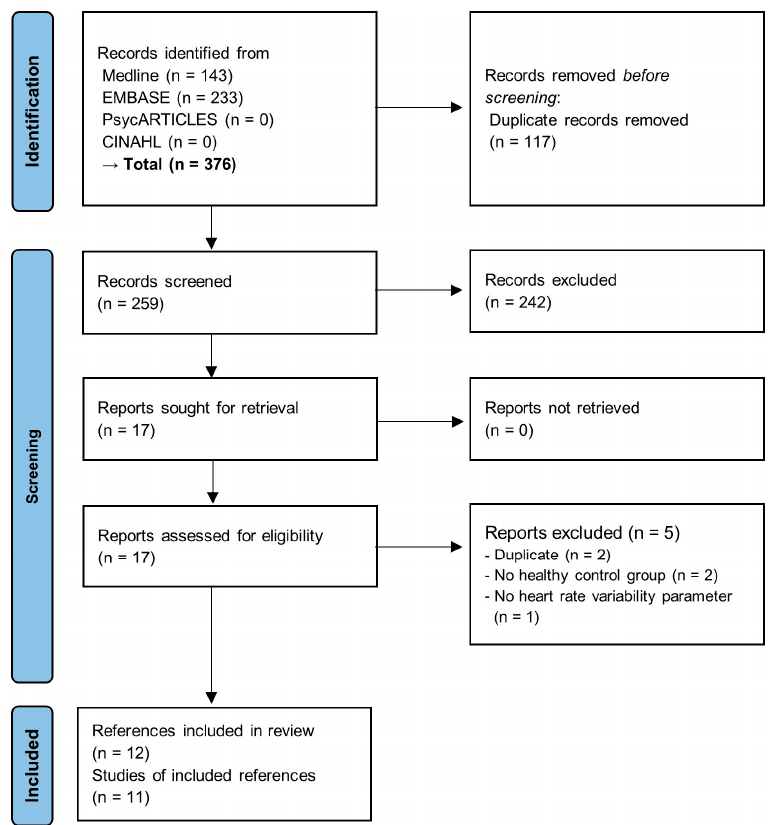
Figure 1. PRISMA flow diagram of the